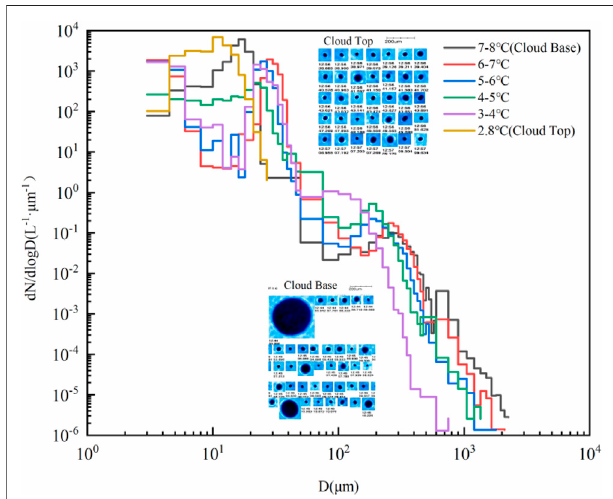
FIGURE 6 | Cloud particle size distribution and cloud particle images in the warm layer from 1,158 to 3,456 m. The colored lines represent cloud particle distribution under different temperatures.